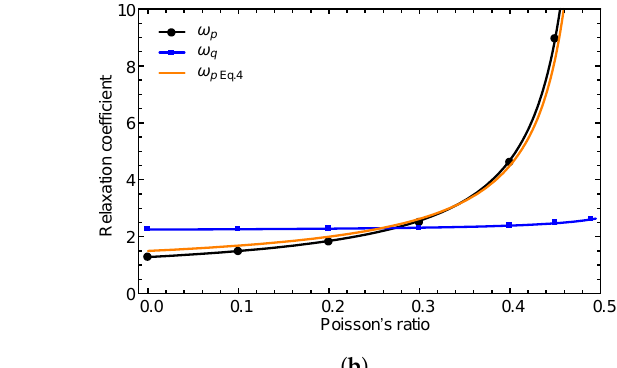
Figure 2. Linear elastic approach for evaluating spherical and deviatoric stress relaxation: ( a ) illustration of the numerical boundary value problem; ( b ) results of ω p and ω q (dots = numerical values, orange line = analytical solution for ω p